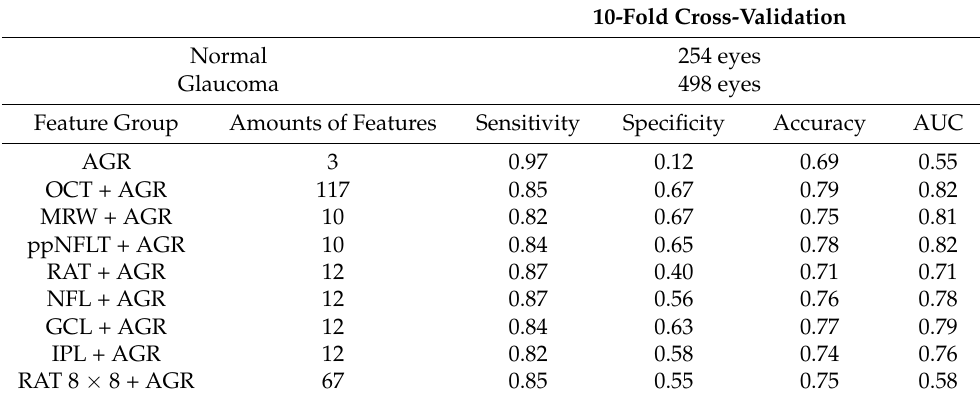
Table 4. OCT-related feature groups (plus age, gender, and refraction) and the SVM classification results. 10-Fold Cross-Validation Normal 254 eyes 498